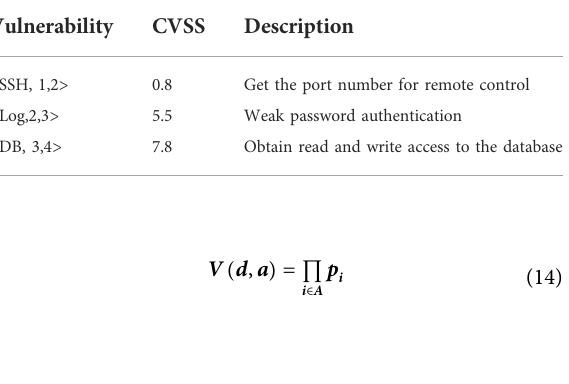
TABLE 1 Information on the vulnerabilities exploited during the